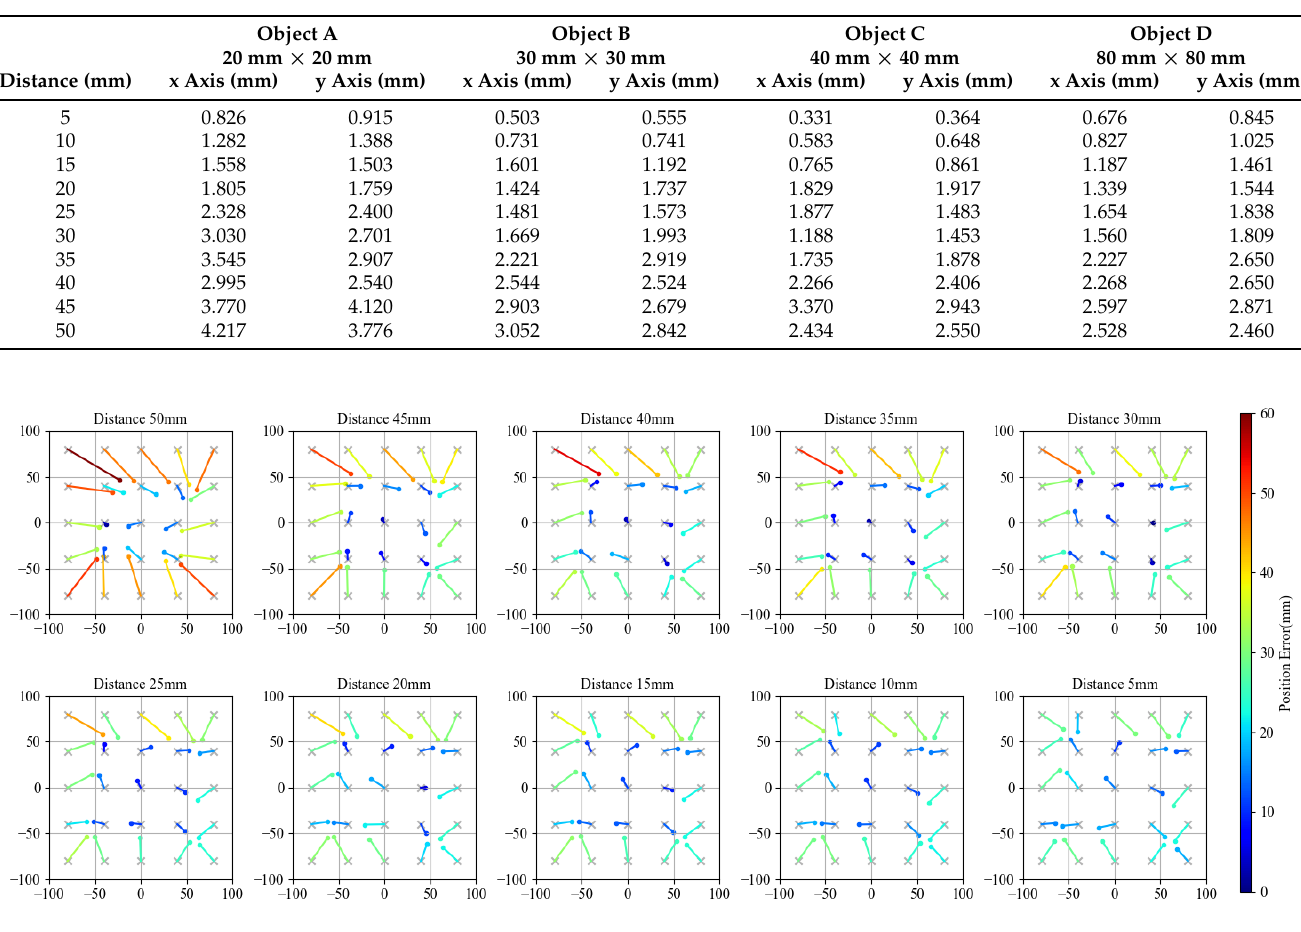
Figure 9. Reconstructed CoP compared with ground truth points in experiment with an 80 mm object. The points and gray crosses represent the reconstructed CoPs and the ground truths, respectively. Units of graphs is in millimeter